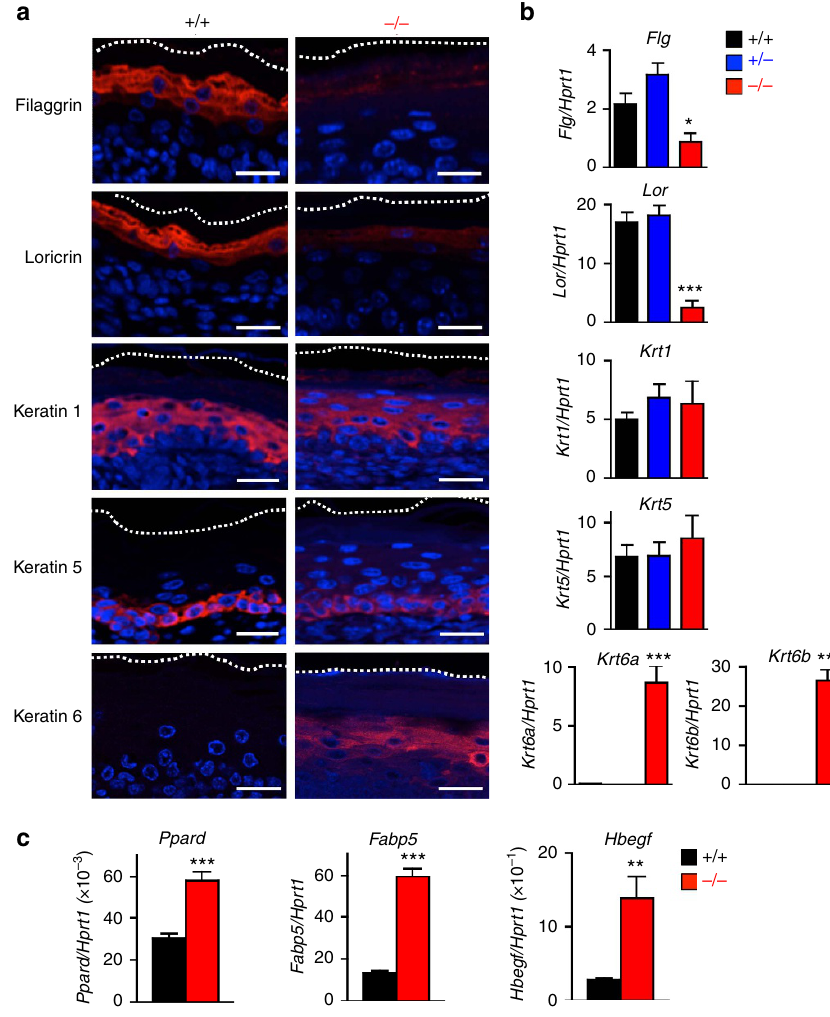
Figure 2 | Aberrant terminal differentiation of Pnpla1 (cid:2) / (cid:2) epidermis. ( a ) Immunohistochemical staining of keratinocyte differentiation markers (red), followed by conterstaining with DAPI (blue), in skin sections from Pnpla1 þ / þ and Pnpla1 (cid:2) / (cid:2) newborn mice. Scale bars, 20 m m. ( b ) qPCR analysis of keratinocyte differentiation markers in newborn Pnpla1 þ / þ , Pnpla1 þ / (cid:2) and Pnpla1 (cid:2) / (cid:2) epidermis ( n ¼ 5 animals per group). ( c ) qPCR analysis of PPAR d ( Ppard ) and its potential target genes in newborn Pnpla1 þ / þ and Pnpla1 (cid:2) / (cid:2) epidermis ( n ¼ 7 animals). In b , c , values are mean ± s.e.m.; * P o 0.05, ** P o 0.01, and *** P o 0.001 versus Pnpla þ / þ mice. Representative results from two or three independent experiments are